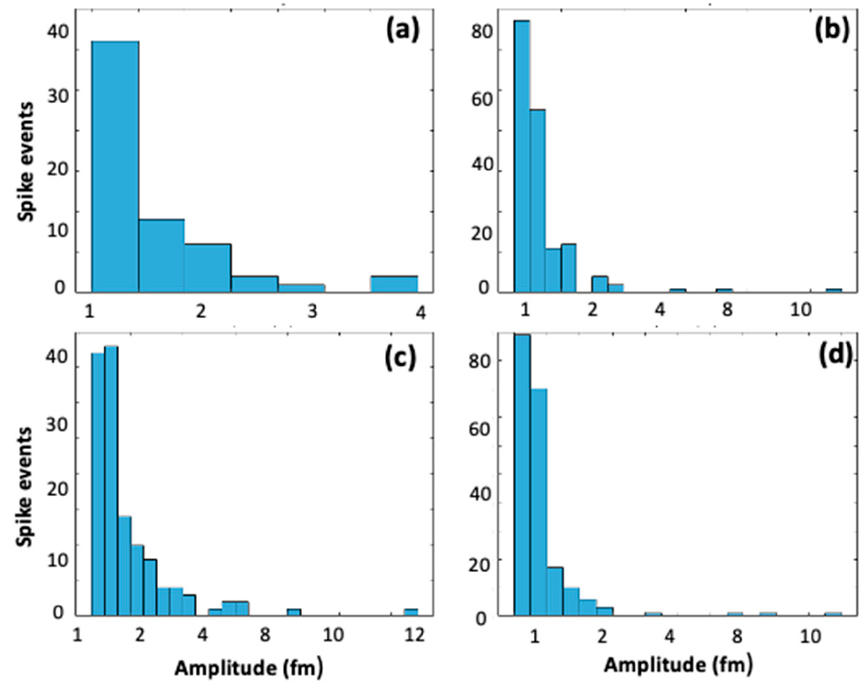
Figure 4. Histograms corresponding to events extracted from time series of ∆ κ , corresponding to increasing Au-NR@HS-Si(OH) n concentrations explored in Figure 3: ( a ) 9 pM, ( b ) 14 pM, ( c ) 18 pM, and ( d ) 28